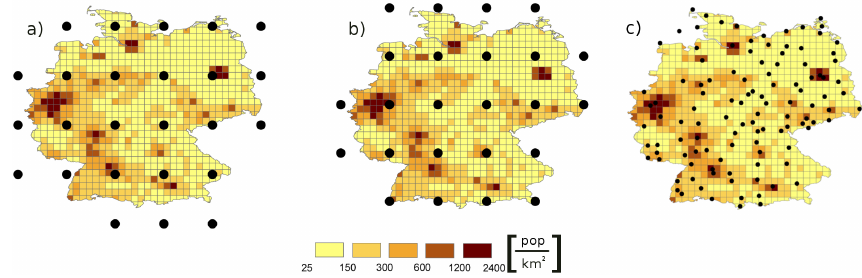
Figure 1. (a) Location of reanalysis grid points (black) over and near Germany and population density (POP, colours) in number of inhab- itantskm − 2 per 0 . 25 ◦ grid cell; (b) same as (a) but for ECHAM5 GCM grid points; (c) same as (a) but for DWD stations. Only stations providing 80% of the wind gust records for the period 1981/82 to 2010/11 are considered (112 stations). For each 0 . 25 ◦ grid cell, the wind/gust is associated using the nearest neighbour